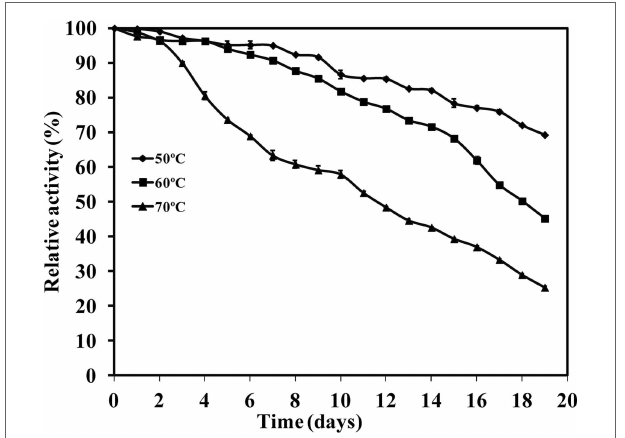
FigUre 6 | hydrolysis of Xylan from Birchwood – comparison of hydrolytic activity of WsUcF1 xylanase, cellic hTec2, and genencor accellerase XY . The points are the averages of duplicates, and error bars indicate ± SDs of the means ( n = 2). Error bars smaller than the symbols are not